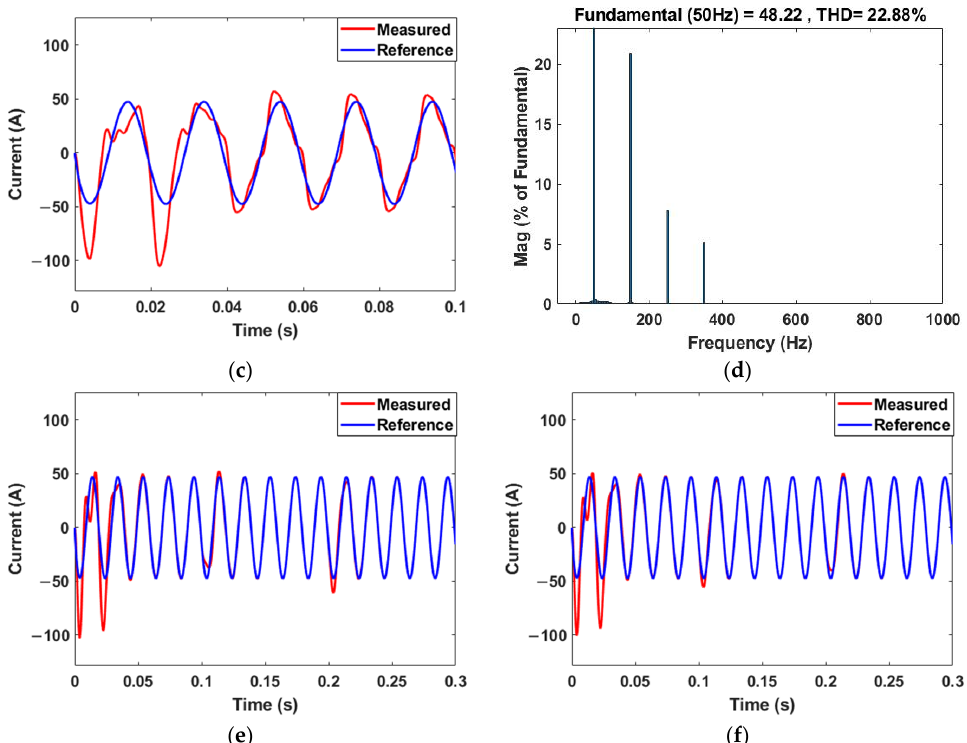
Figure 9. Output current I 2 using the PI controller: ( a ) under NGO; ( b ) during step response at 0.15 s; ( c ) under AGO; ( d ) THD of AGO response; ( e ) during voltage sag and ( f ) voltage swell in grid voltage.